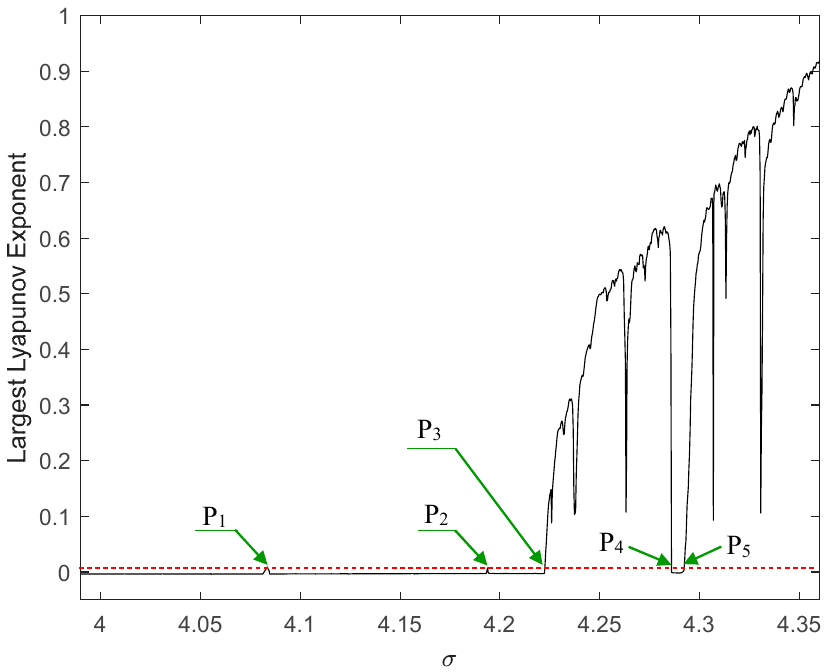
Figure 8. Evolutions of largest Lyapunov exponent.